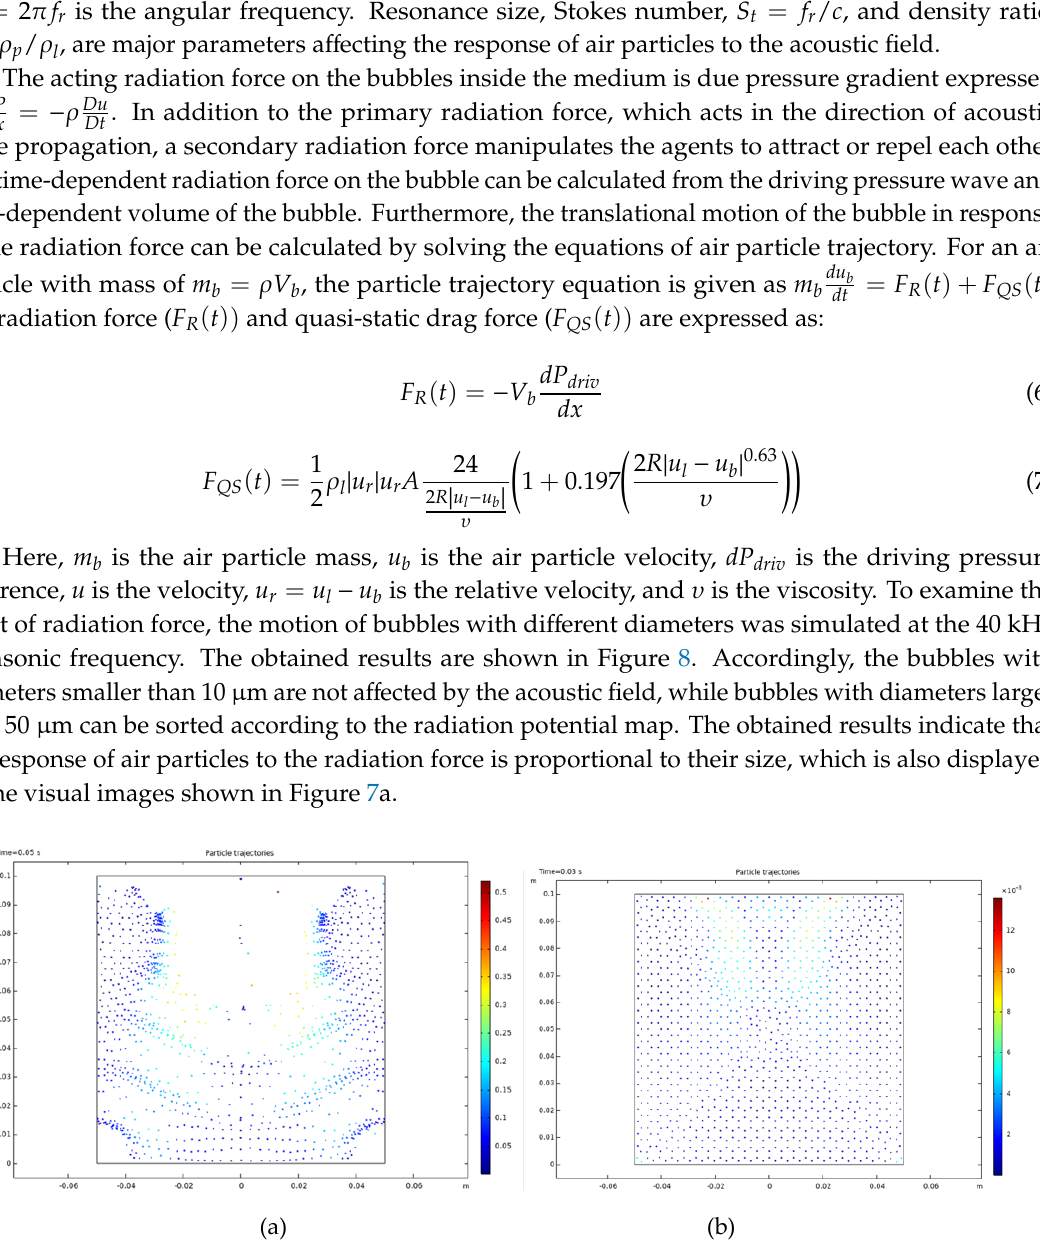
(b) Figure 7. Bubble cloud formation ( a ) experimental results ( b ) numerical results for the response of